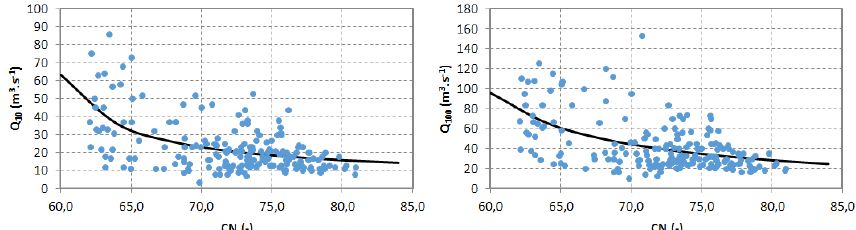
Figure 6. Relationship between catchment average CN value and peak discharge value for T = 10 years (left panel) and T = 100 years (right panel) with fitted lines following Eq. (2).